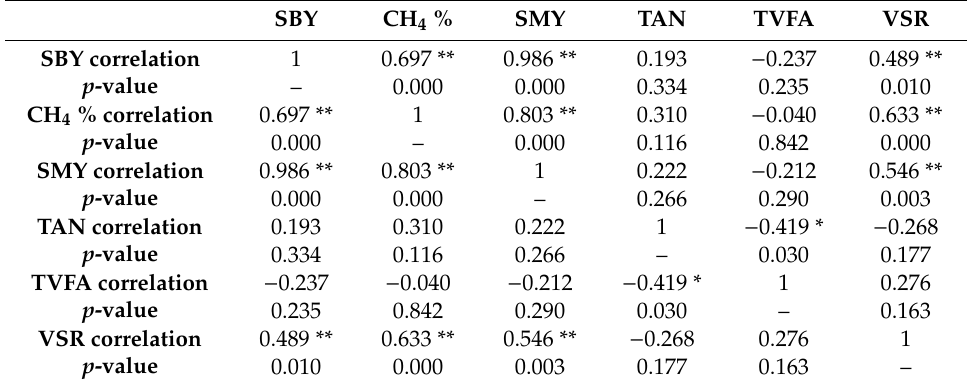
Table 6. Pearson’s correlation matrix with correlation indices and significance between